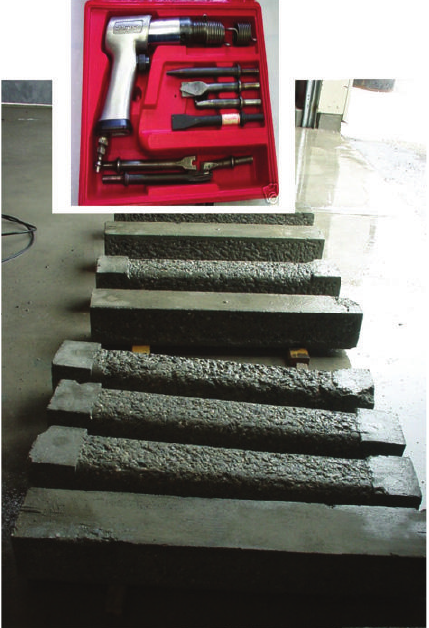
Figure 11: Surface preparation using pneumatic concrete chisel.